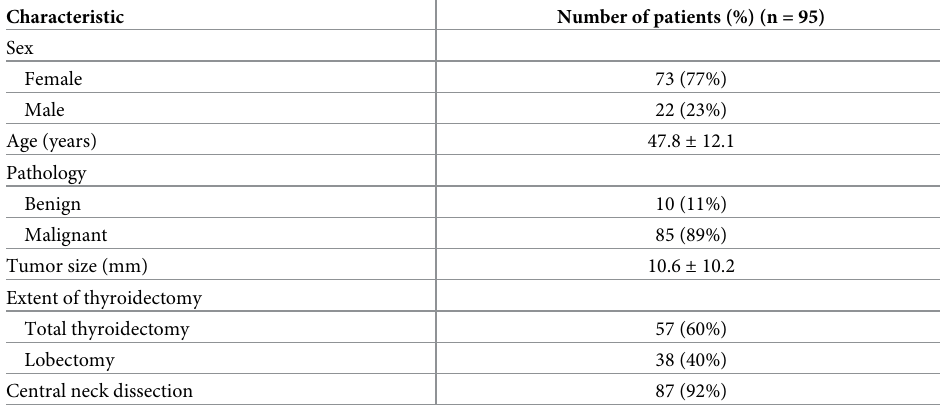
Table 1. The clinicopathologic characteristics of patients and surgical